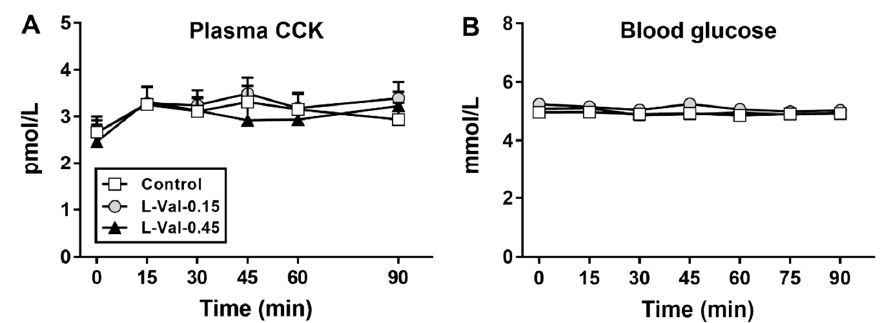
Figure 3. Plasma CCK ( A ) and blood glucose ( B ) concentrations during 90-min intraduodenal infusions of L-valine at 0.15 kcal/min (“L-Val-0.15”) or 0.45 kcal/min (“L-Val-0.45”), or control. Repeated-measures two-factor ANOVA, with treatment and time as factors, was used to analyse the data. Post-hoc comparisons, adjusted for multiple comparisons by Bonferroni correction, were used to determine significant differences between treatments if ANOVAs were significant. Statistical significance was accepted at p < 0.05. Data are means ± SEMs, n = 11 for CCK (due to technical difficulties with blood sampling), n = 12 for